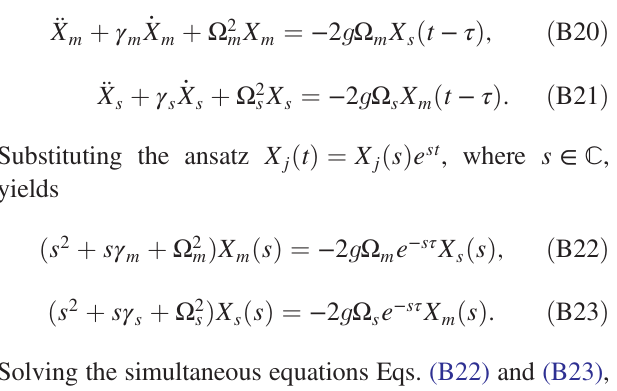
FIG. 8. Evaluation of the stability of the coupled system using the Routh-Hurwitz criterion. The colored regions (i.e., region above each solid line) show the sets of parameters for which the coupled dynamics is stable for a given value of the feed- back delay. Without propagation delay, every set of detunings and spin damping leads to stable dynamics. For τ ¼ 80 ns τ ≈ 1 ; thus the validity of the Taylor expansion we have Ω m of the exponential function in the presence of small delays reaches its limit. For the stability estimations shown here we ¼ 2 π × 262 Hz, and Ω ¼ 2 π × used 2 g ¼ 2 π × 6 . 8 kHz, γ m m 1 . 957